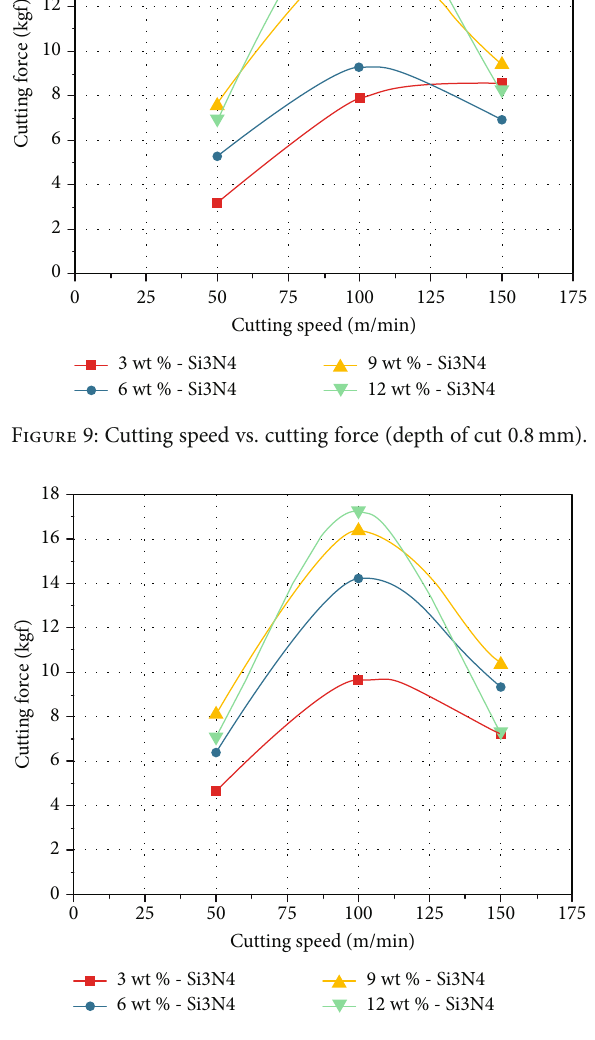
Figure 12: Cutting speed vs. cutting force (depth of cut